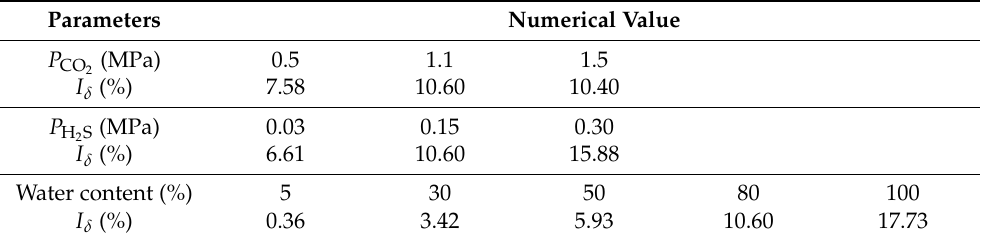
Table 5. The SCC susceptibility of L80 steel under different conditions.